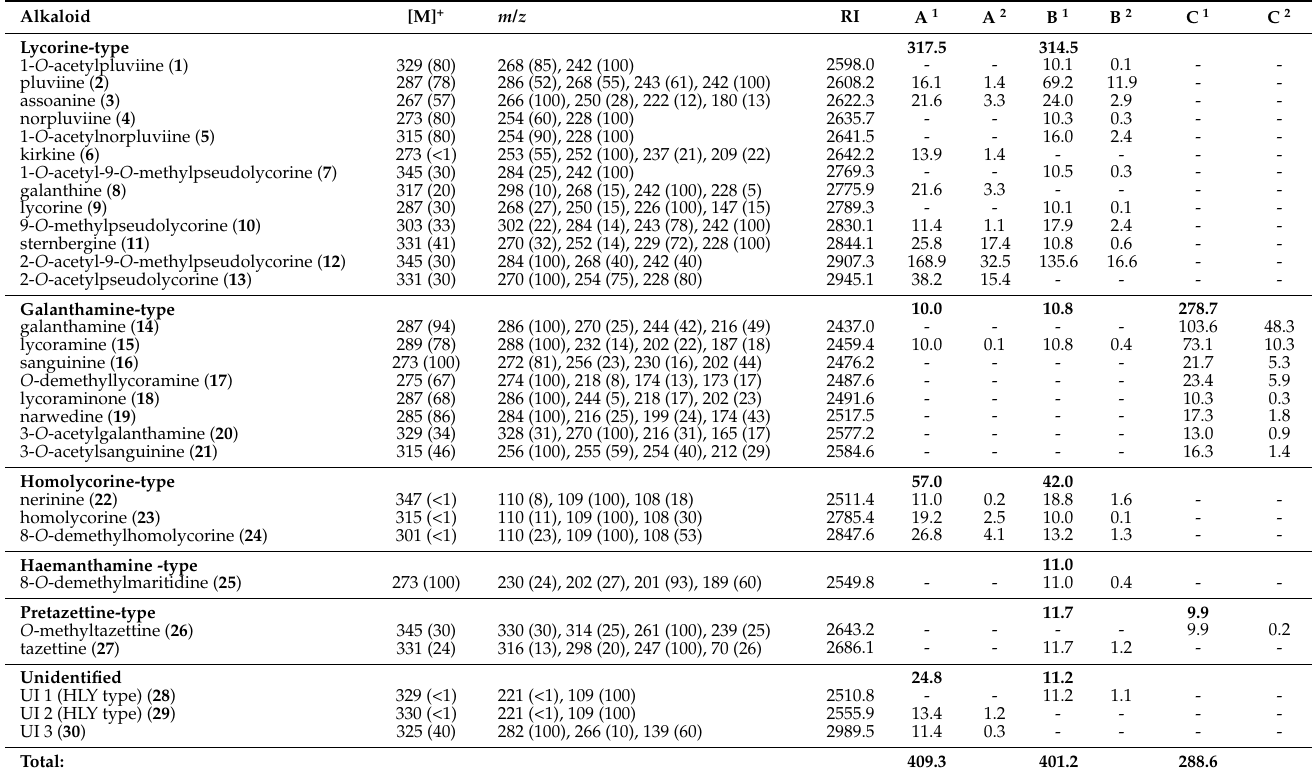
Table 1. Alkaloid profile of Rauhia species by